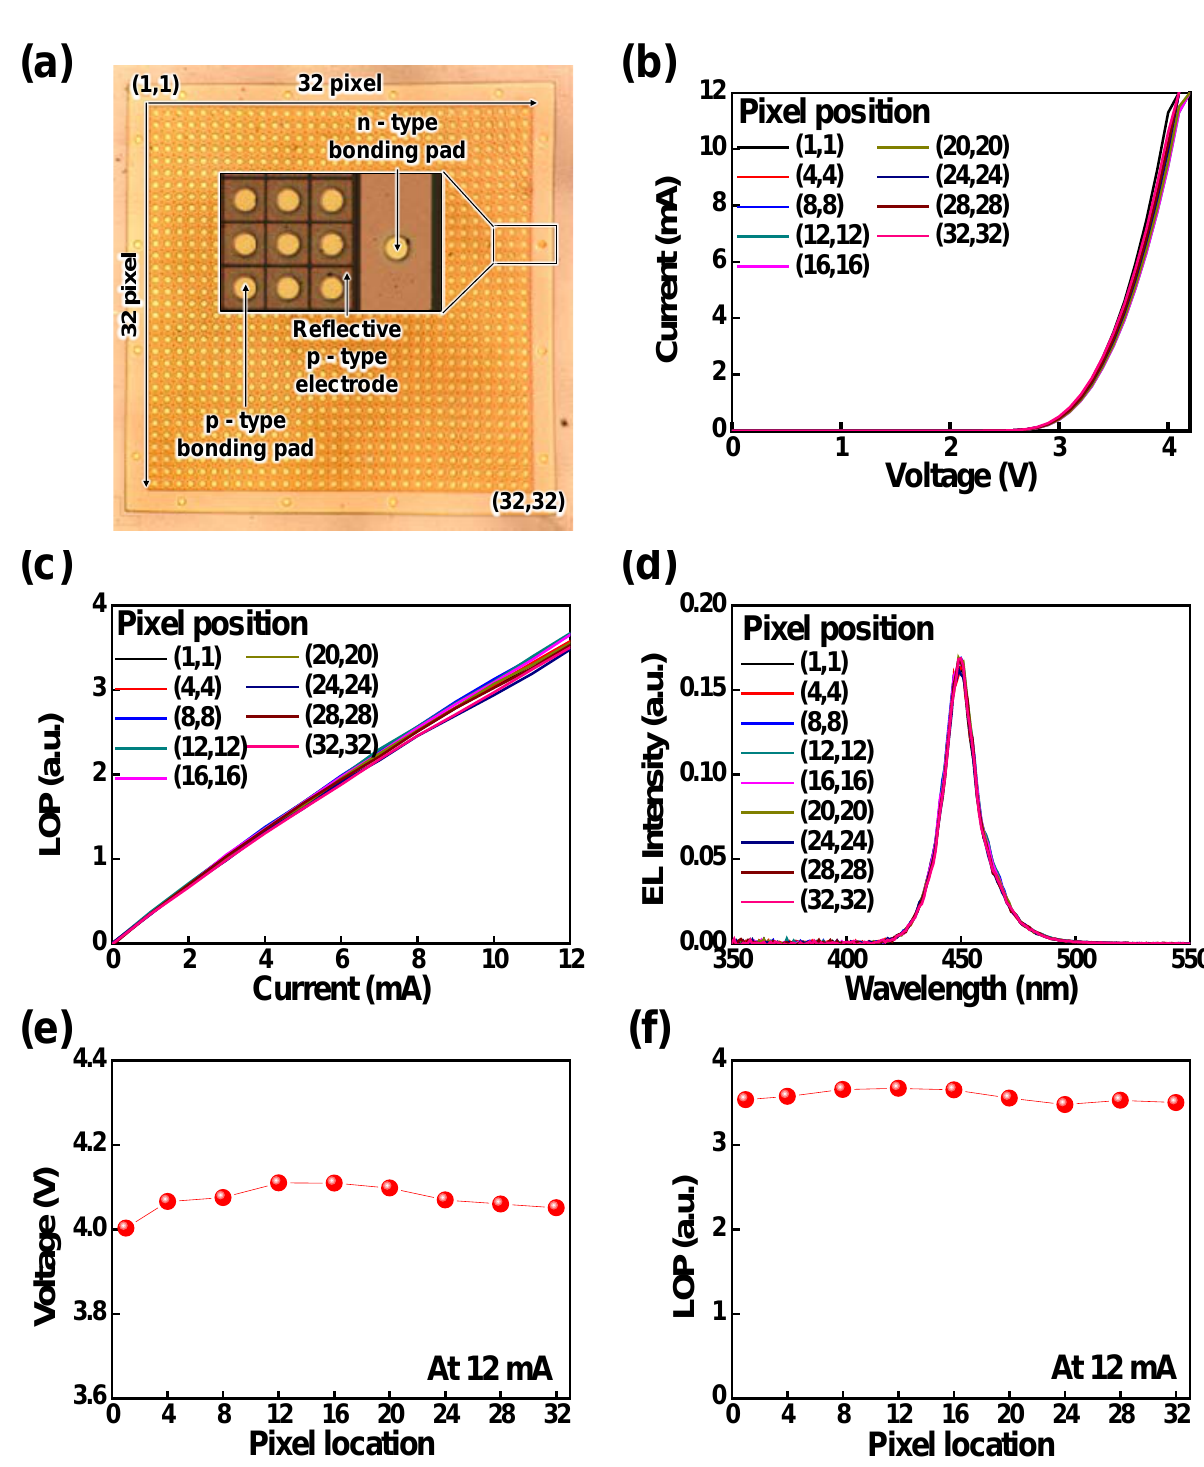
Figure 5. ( a ) Optical microscope image of 32 × 32 pixelated µ -LED arrays. ( b ) I–V characteristics, ( c ) LOP characteristics, and ( d ) EL spectra of the fabricated µ -LED arrays for various pixel positions. ( e ) Forward voltage and ( f ) LOP characteristics at 12 mA for various pixel positions of the fabricated µ -LED arrays.